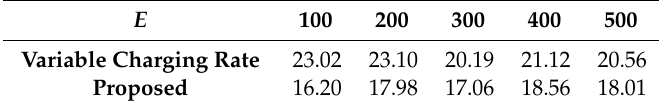
Table 6. Comparison for Average Time Intervals required to Achieve Final SoC.